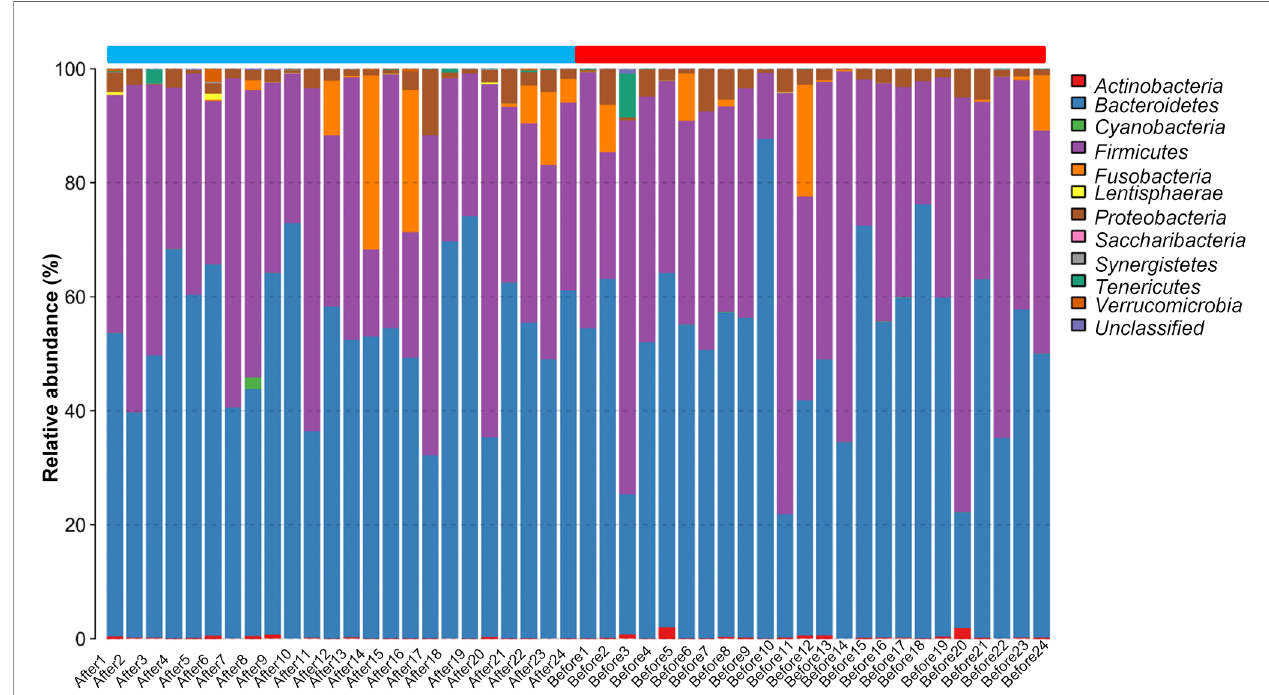
FIGURE 2 | The taxonomic composition distribution in samples at the phylum level. The abscissa represents the Sample Number. Before presents pre-intervention, After presents post-intervention. The 48 samples are divided into two parts. The blue part is from After1 to After24, and the red part is from Before1 to Before24. The legend in the upper right corner represents the name of the species at the phylum level. The content of the bacteria is displayed in the histogram in the corresponding proportion and color.